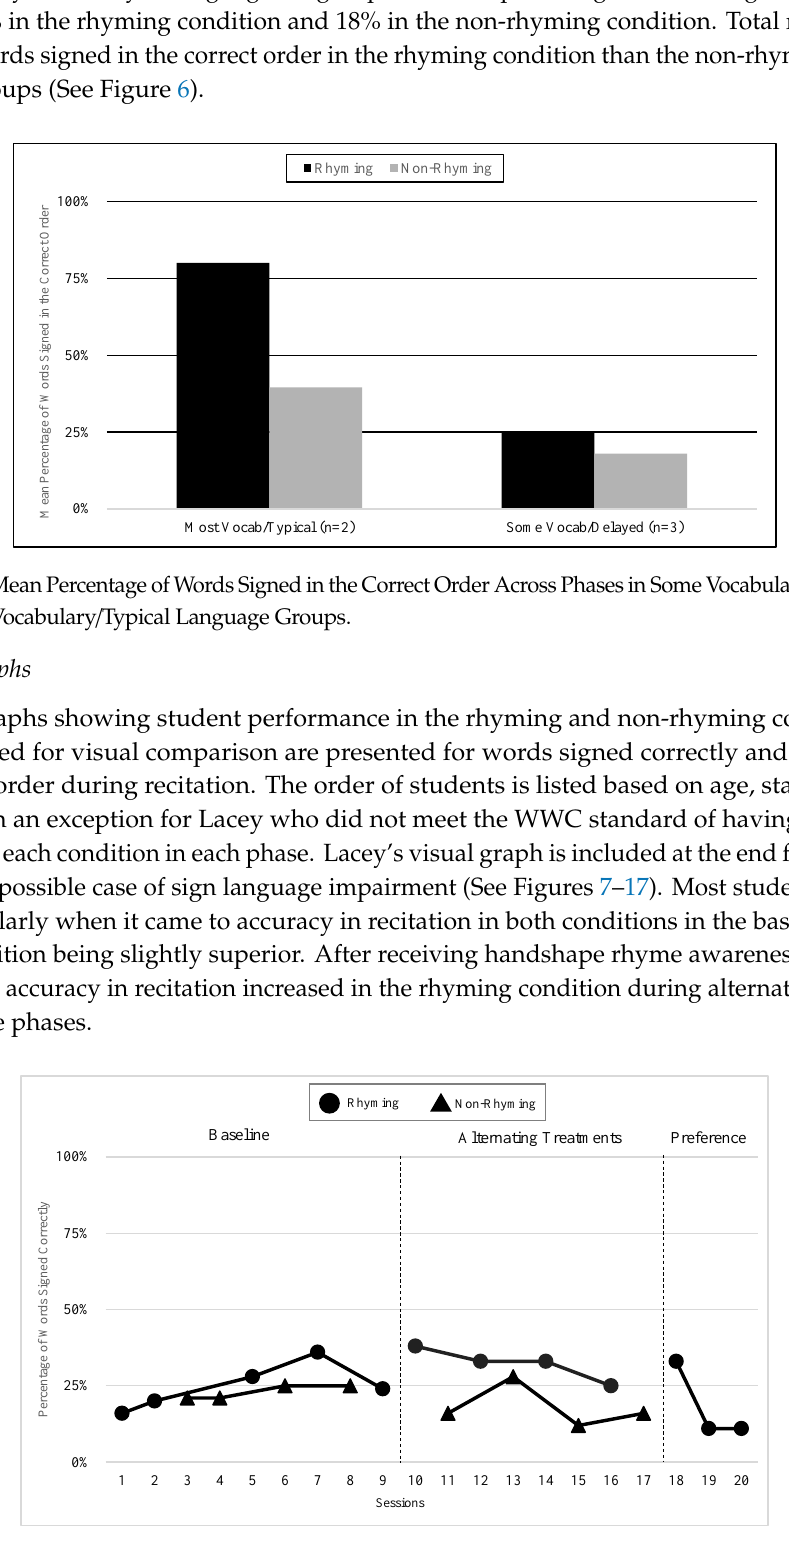
Figure 5. Mean Percentage of Words Signed in the Correct Order in Rhyming and Non-Rhyming Conditions in Each Phase and Across Phases. In the most vocabulary and typical language subgroup, the mean percentage of words signed in the correct order was 80% in the rhyming condition and 39% in the non-rhyming condition. In the some vocabulary and delayed language subgroup, the mean percentage of words signed in the correct order was 25% in the rhyming condition and 18% in the non-rhyming condition. Total means seem to show more words signed in the correct order in the rhyming condition than the non-rhyming condition in both subgroups. (See Figure 6).